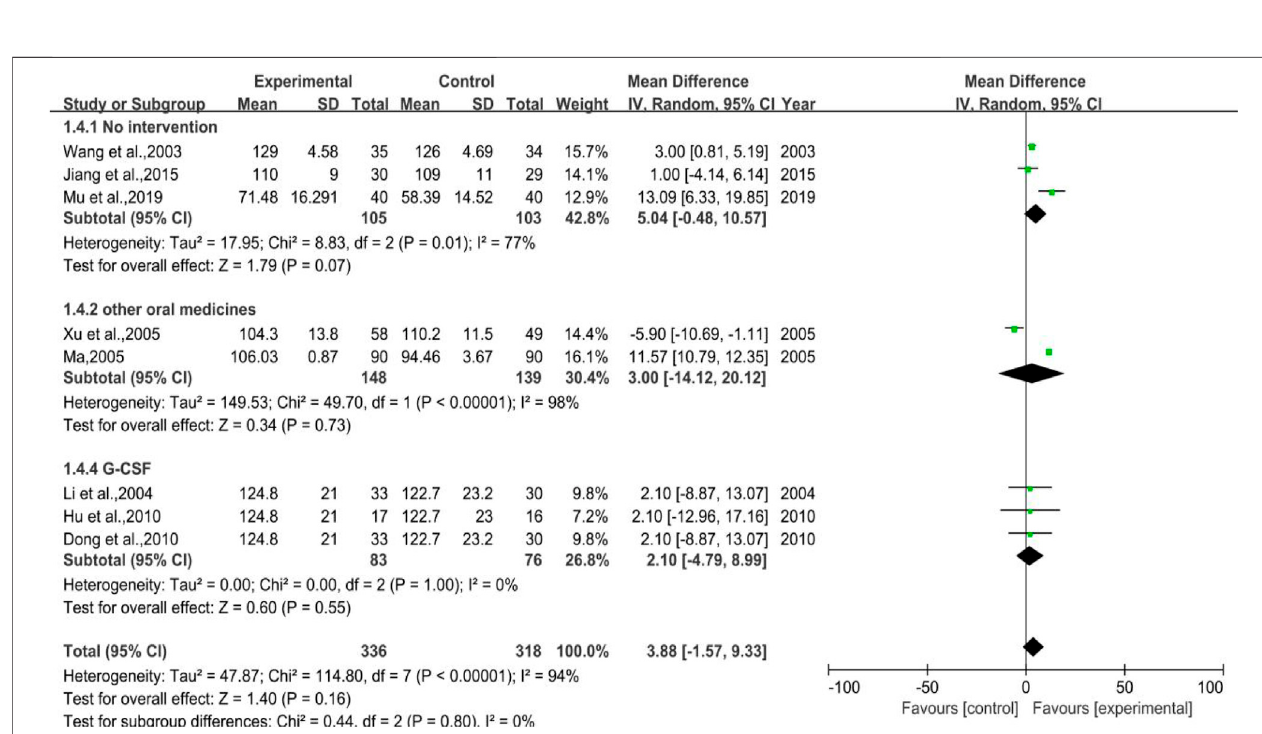
Frontiers in Pharmacology |